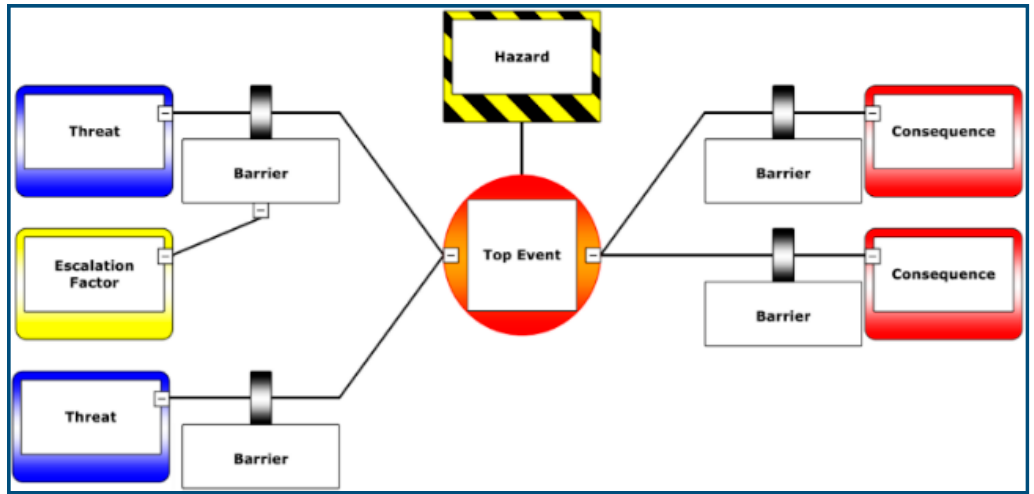
Figure 3. Bowtie risk assessment model [14].